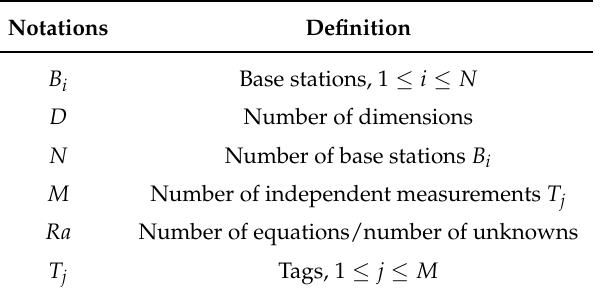
Table 1. Notations used in the text and in the equations.